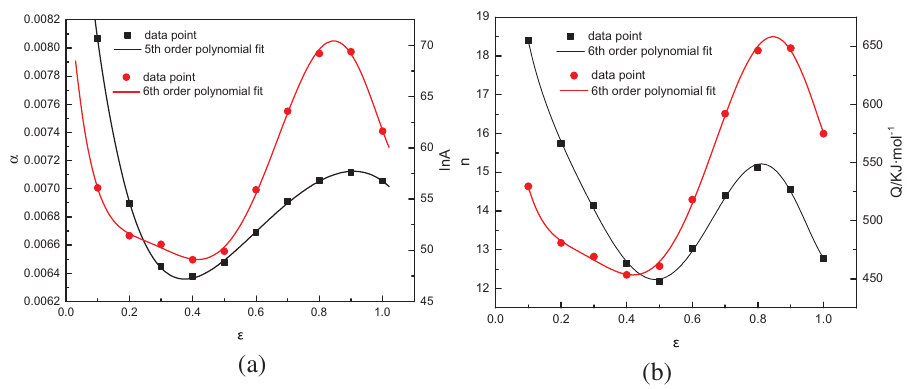
Figure 19: Variation of (a) α and ln A ; (b) n and Q with true strain.